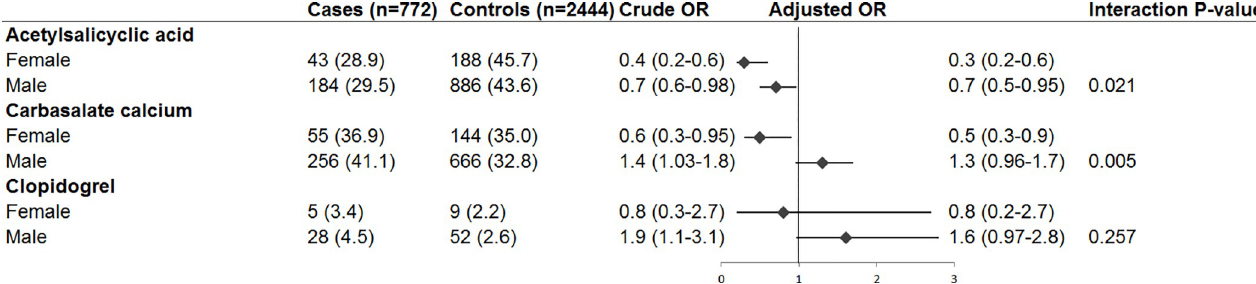
Fig 3. Current use of acetylsalicylic acid, carbasalate calcium or clopidogrel and out-of-hospital cardiac arrest risk compared with no current use of any antiplatelet drugs: Stratified according to sex. Not included in the figure: current users of other antiplatelet monotherapy (e.g., dipyridamole, ticlopidine) among cases and controls, and current users of � 2 antiplatelet drugs among cases and controls. Abbreviations: CI, confidence interval; OR, odds ratio. Numbers in table are number (%) unless indicated otherwise. Error bars denote 95% confidence interval. Numbers are number (%) unless indicated otherwise.